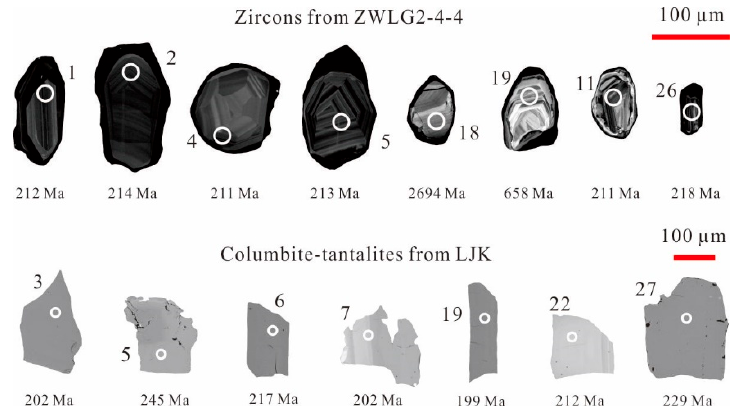
Figure 9. Cathodoluminescence images of representative zircons and columbite–tantalites from the Zhawulong deposit. White circles indicate the analytical spots that provide the measured ages below each image.